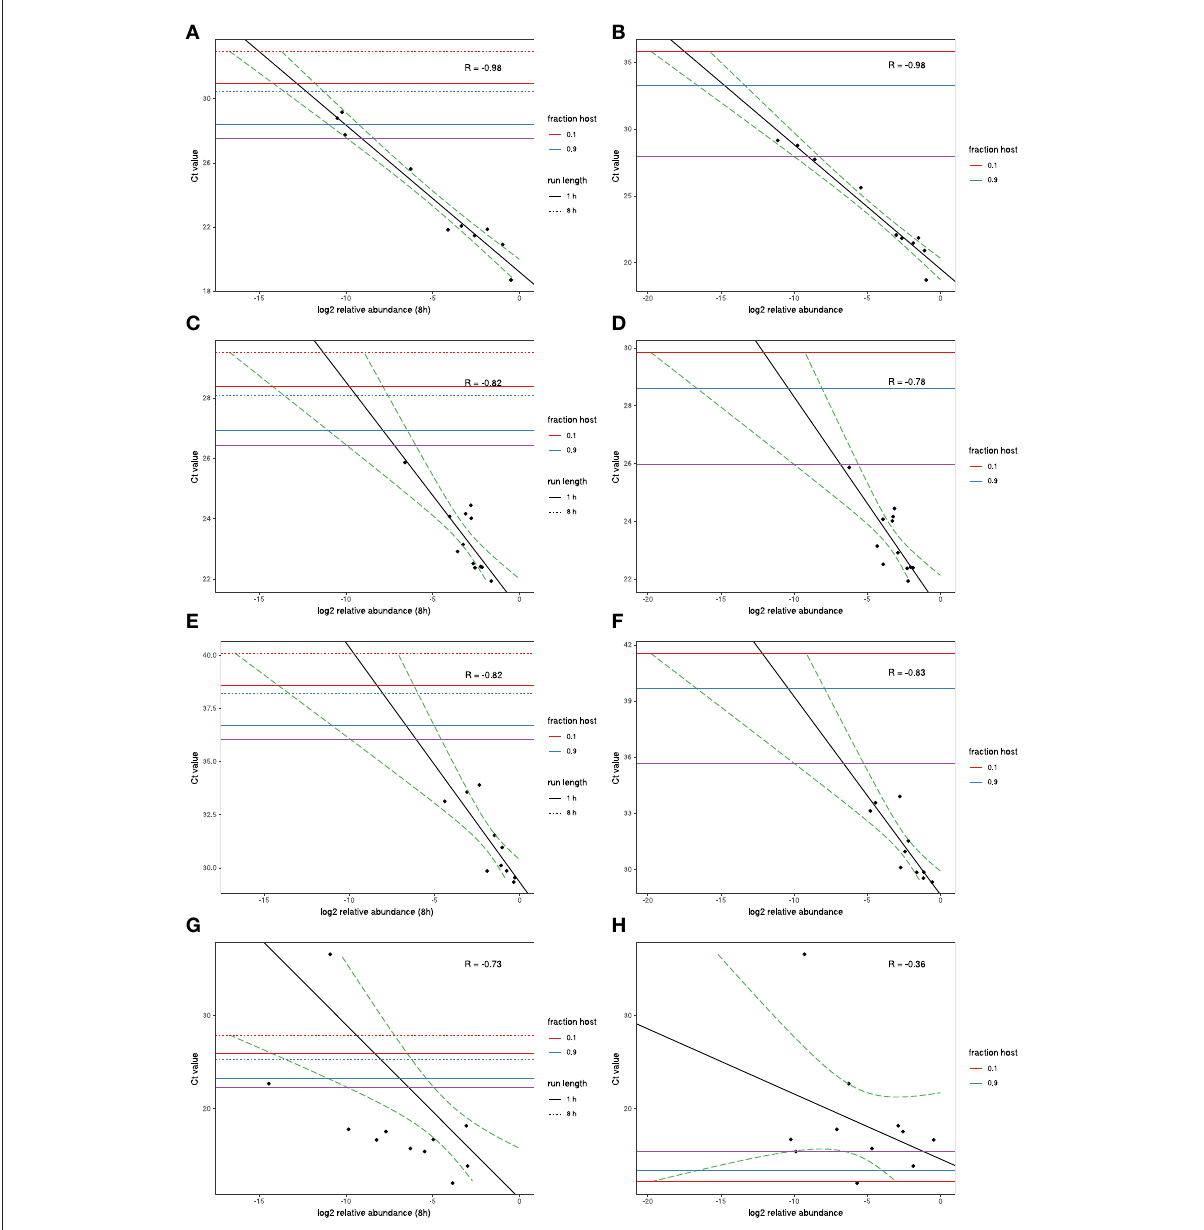
FIGURE1 MinION and MiSeq read abundance vs RT-PCR Ct; for Avian Influenza virus (A,B) ; for Infectious bronchitis virus (C,D) ; for Mycoplasma synoviae (E,F) in experimental samples and for Newcastle disease virus (G,H) in clinical samples. Black line indicates best-fit linear regression model. Red/blue horizontal lines mark Ct thresholds at which a single read would be estimated to be observed with 95% confidence at different run times and levels of host contamination, given current experimental conditions, and assuming 12 multiplexed samples. Purple horizontal line marks Ct threshold corresponding to on average one agent read per thousand microbial reads at 95% confidence.